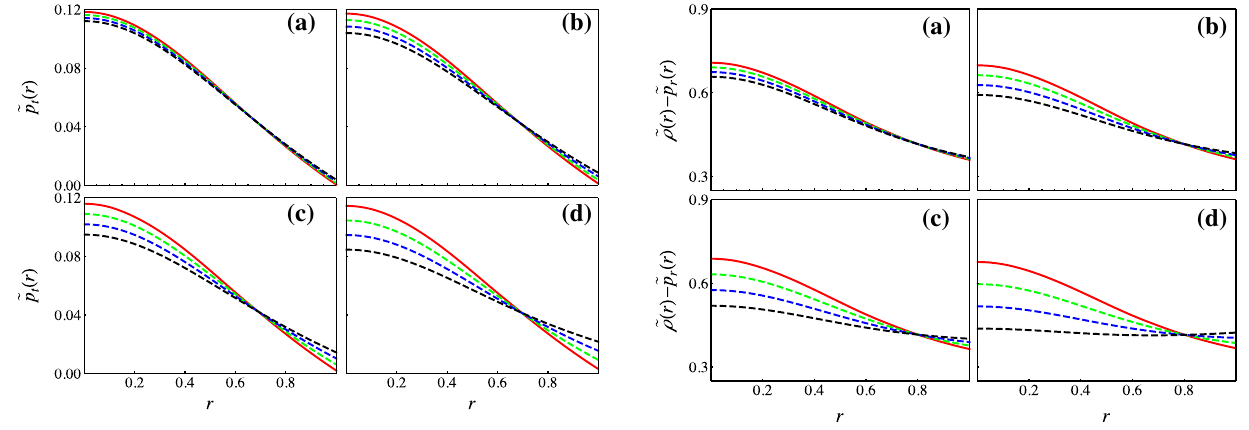
Fig. 5 DEC for M = 0 . 2, R = 1, c 1 = 0 . 5 and a C = − 0 . 1, b C = − 0 . 2, c C = − 0 . 3, d C = − 0 . 4. α = 0 . 1 (red line), α = 0 . 3, (green line), α = 0 . 5 (blue line), α = 0 . 7 (black